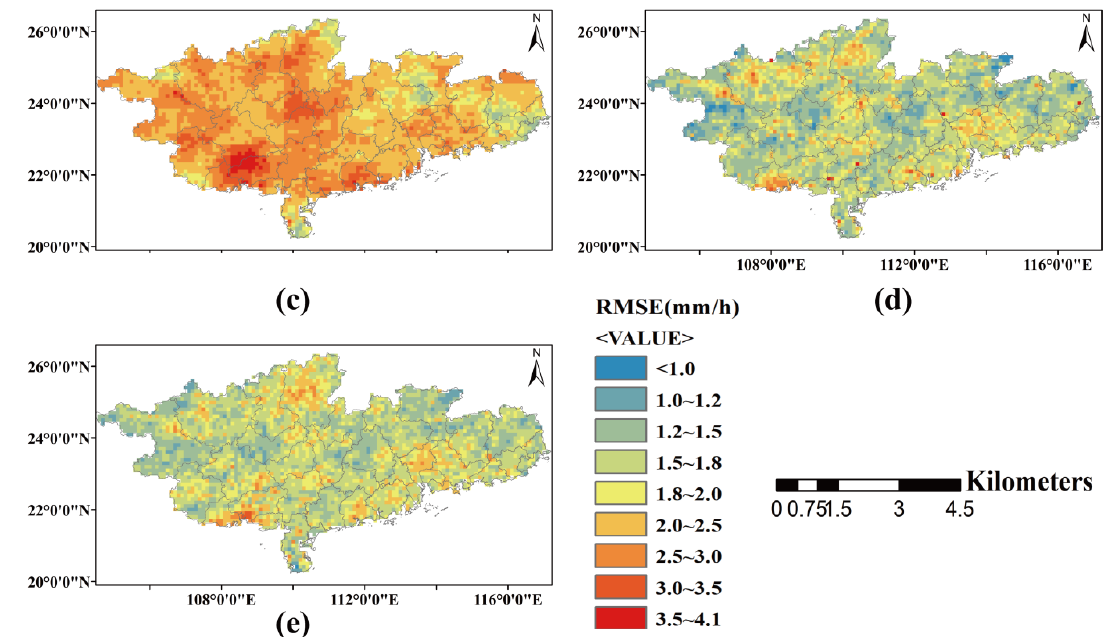
Figure 8. Spatial patterns in terms of root-mean-square error (RMSE) based on ( a ) PERSIANN-CCS, ( b ) ERA5-Land, ( c ) FY-4A, ( d ) GSMaP, and ( e ) IMERG against CMPA at hourly scale over southern China in summer 2019.